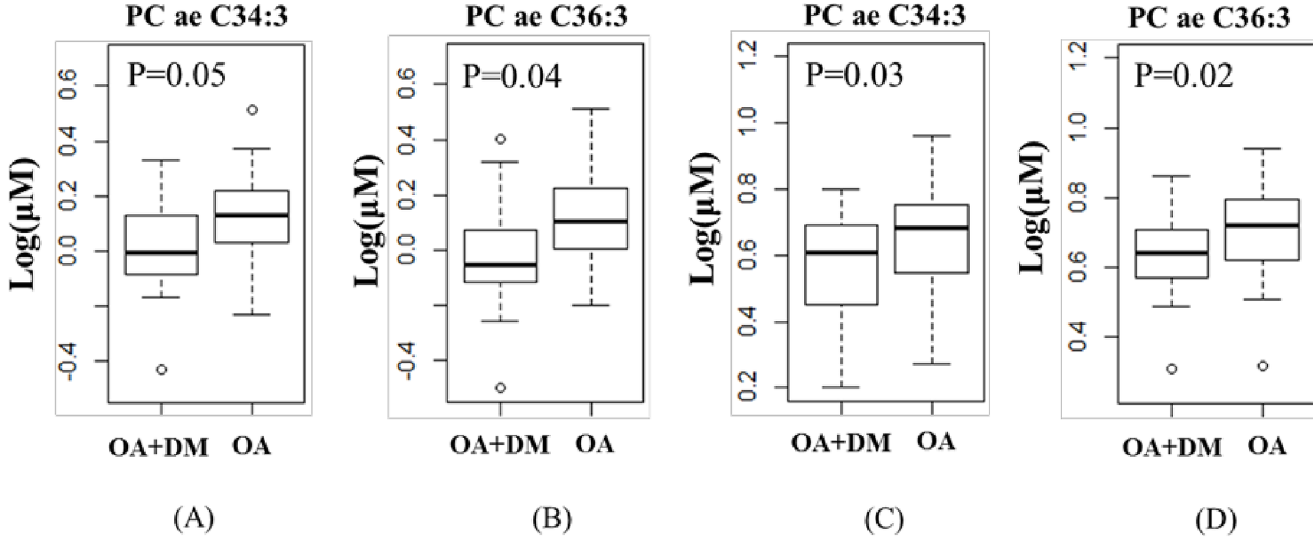
Fig 2. The concentrations of PC ae C34:3 and PC ae C36:3 in SF (A and B) and plasma (C and D) of OA and OA+DM patients. (DM: diabetes). P values were adjusted for sex, age and BMI.